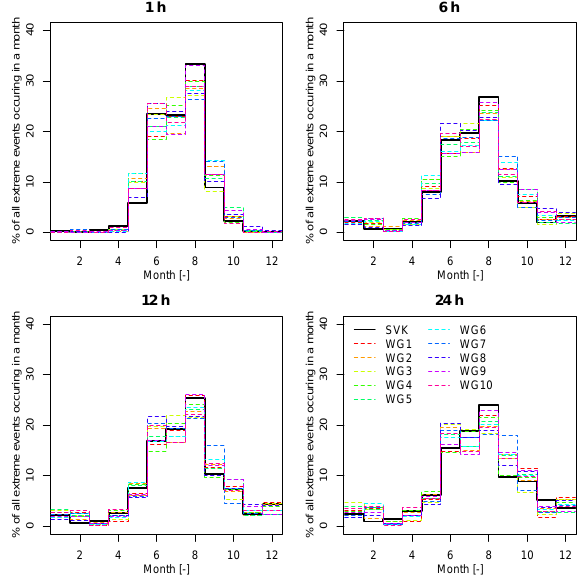
Figure 8. Monthly variation for 1, 6, 12, and 24h durations of the frequency of extreme events in the SVK and WG data sets.